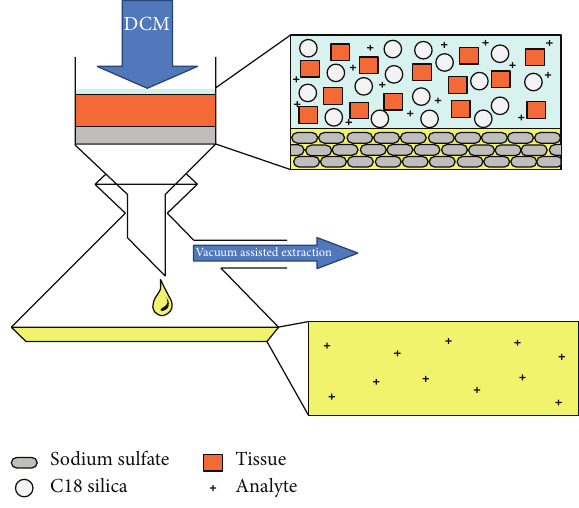
Figure 1: Extraction